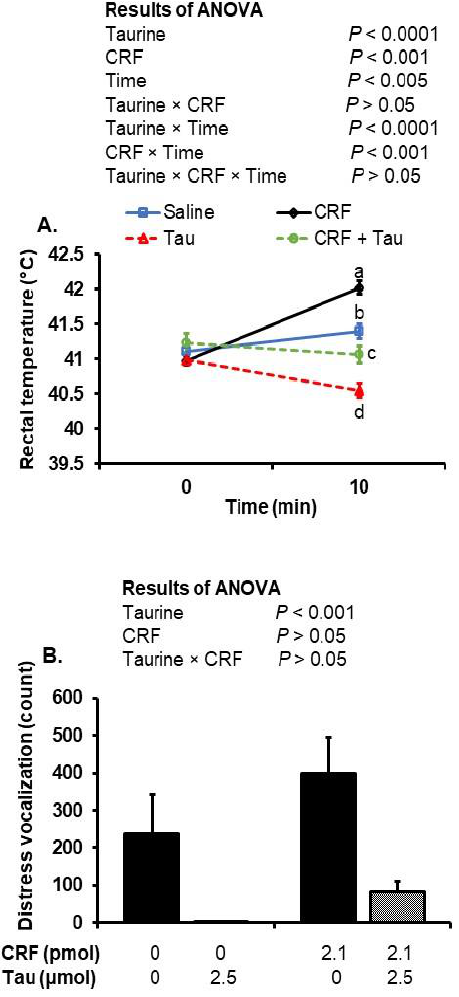
Figure 1. Rectal temperature ( A ) and distress vocalization ( B ) of chicks following the ICV injection of saline (control), taurine (2.5 µ mol), CRF (2.1 pmol) or CRF plus taurine under social isolation stress. Values are expressed as mean ± SEM from chick groups (8–10). Means with different superscripts indicate statistically significant differences ( p < 0.05). Tau, taurine; CRF, corticotropin-releasing factor.